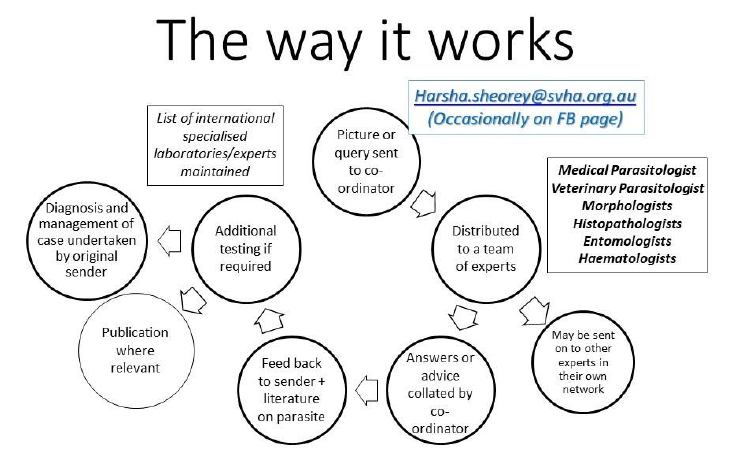
Figure 2. The way e-Diagnosis works.